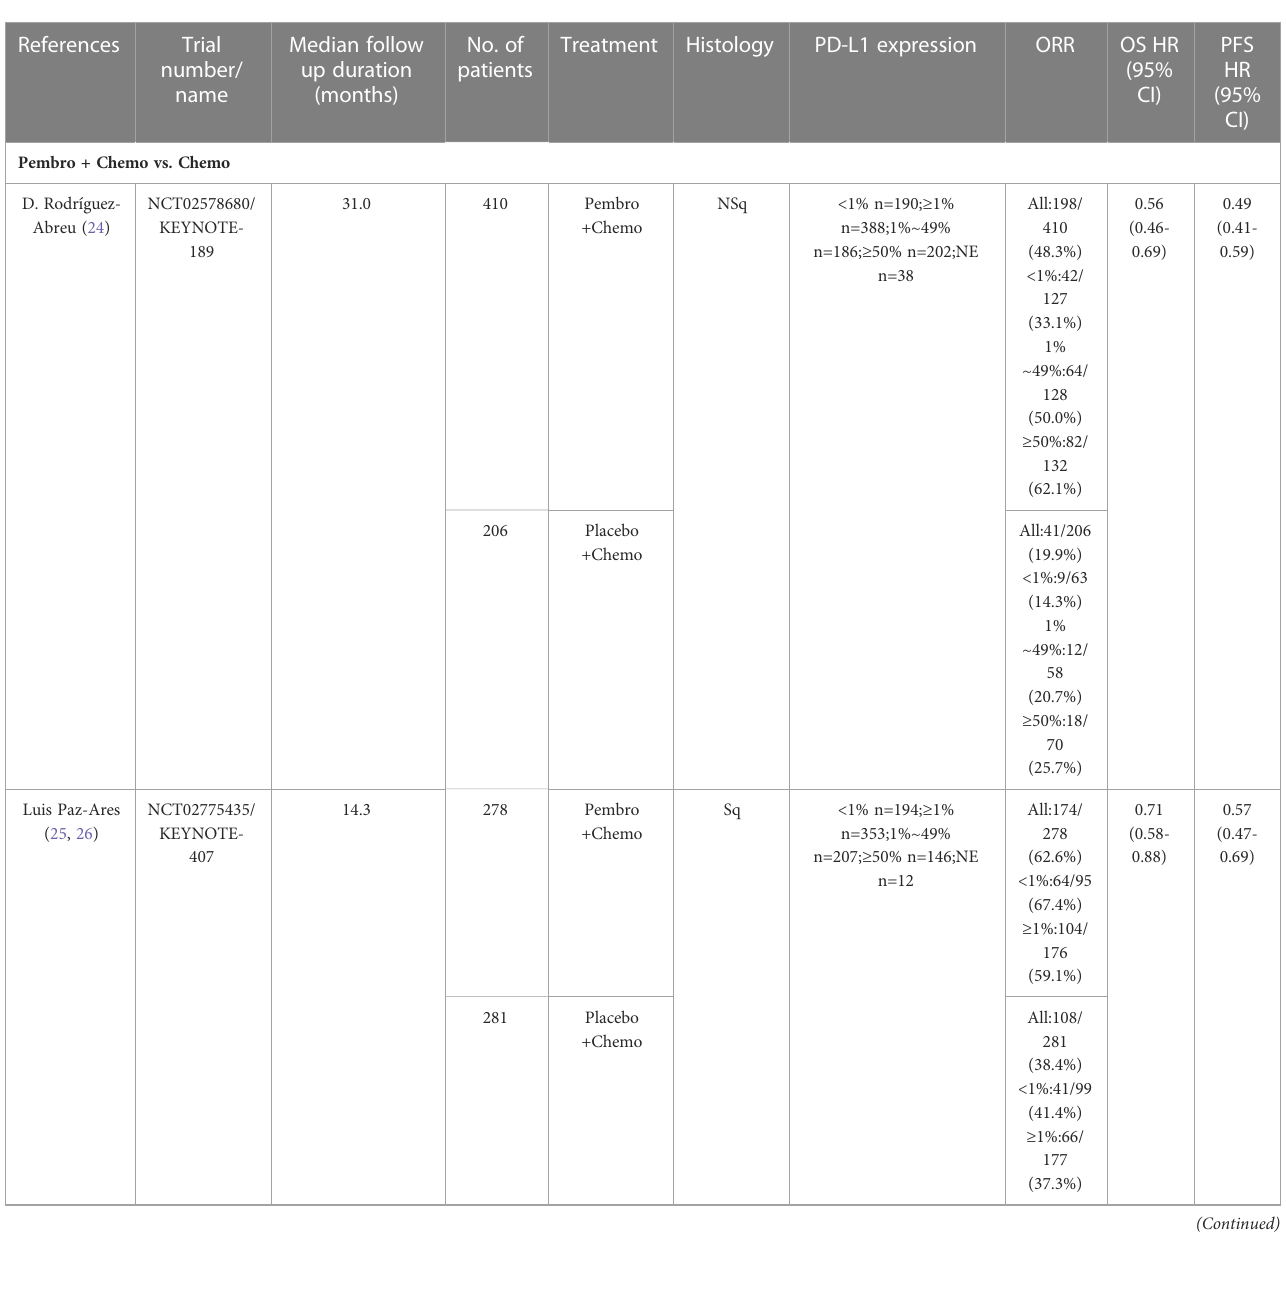
TABLE 1 Characteristics of RCT